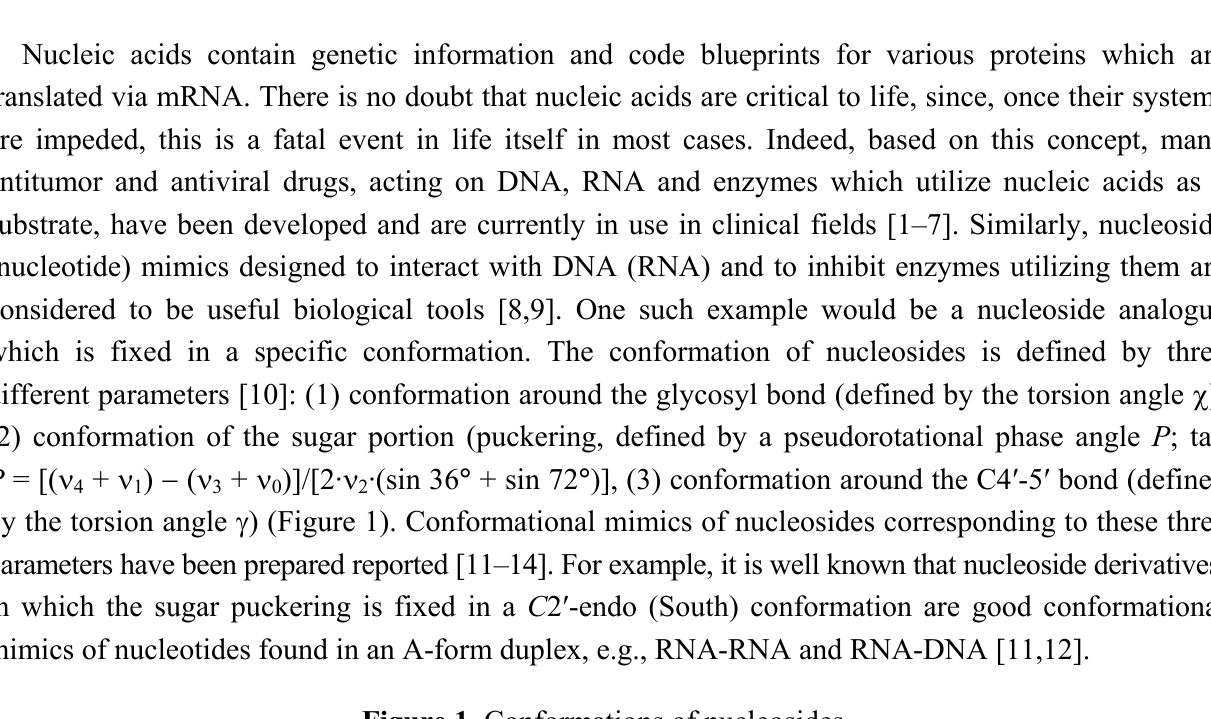
Figure 1. Conformations of